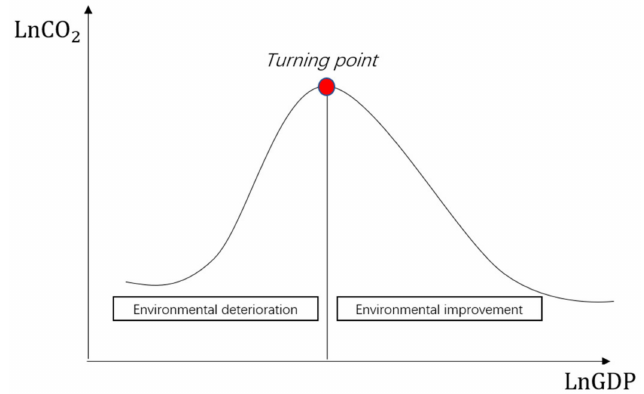
Figure 6. EKC basic curve diagram.